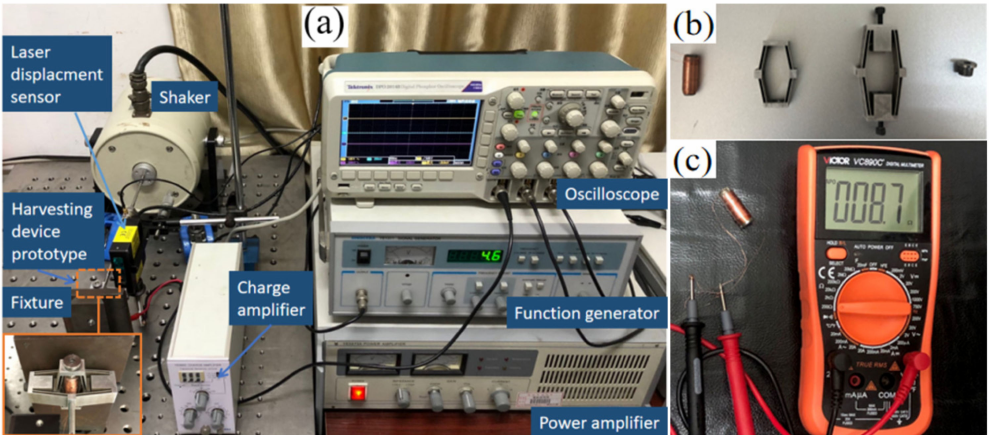
Figure 13. Double-stage rhombus energy harvesting device and experimental setup. ( a ) Photograph of experimental setup; ( b ) Component parts; ( c ) Pick-up coil resistance values.